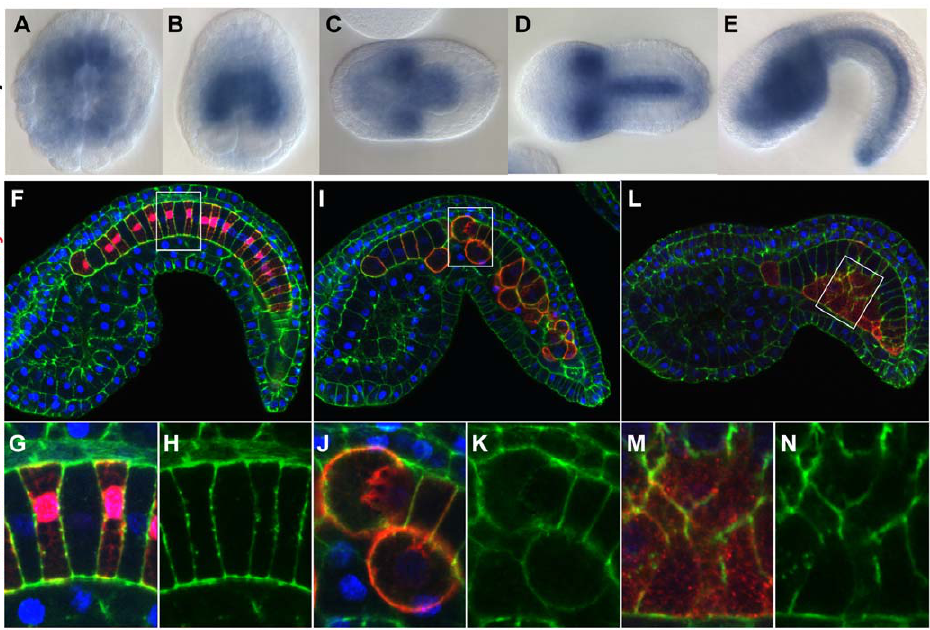
Figure 4. Eph4 D C misexpression caused morphological defects in notochord cells. (A–E) In situ hybridization of early gastrula (A), late gastrula (B), middle neurula (C), early tailbud (D) and middle-late tailbud (E) stage embryos for Ci-Eph4 demonstrating its preferential expression in notochord lineage cells before and during the cell intercalation process. A is a vegetal view with anterior to the top. B–D are dorsal views with either anterior to the top (B) or to the left (C, D). E is a lateral view with anterior to the left. (F–N) Confocal section images of embryos misexpressing EGFP (F), Eph4 D C (I) or XDshD2 (L) triple-stained with anti-myc for Eph4 D C or XDshD2 (red in F and I), phalloidin for actin (red in F, green in F and I) and DAPI for nuclei (blue). Anterior is to the left. (G,J,M) Higher magnification images of the boxed area in F, I and J, respectively. (H,K,N) as G,J,M but only phalloiding signal demonstrating that Eph4 D C and XDshD2 give rise to defects in morphology and intercalation patterns of notochord cells but phenotypes induced by each transgene are